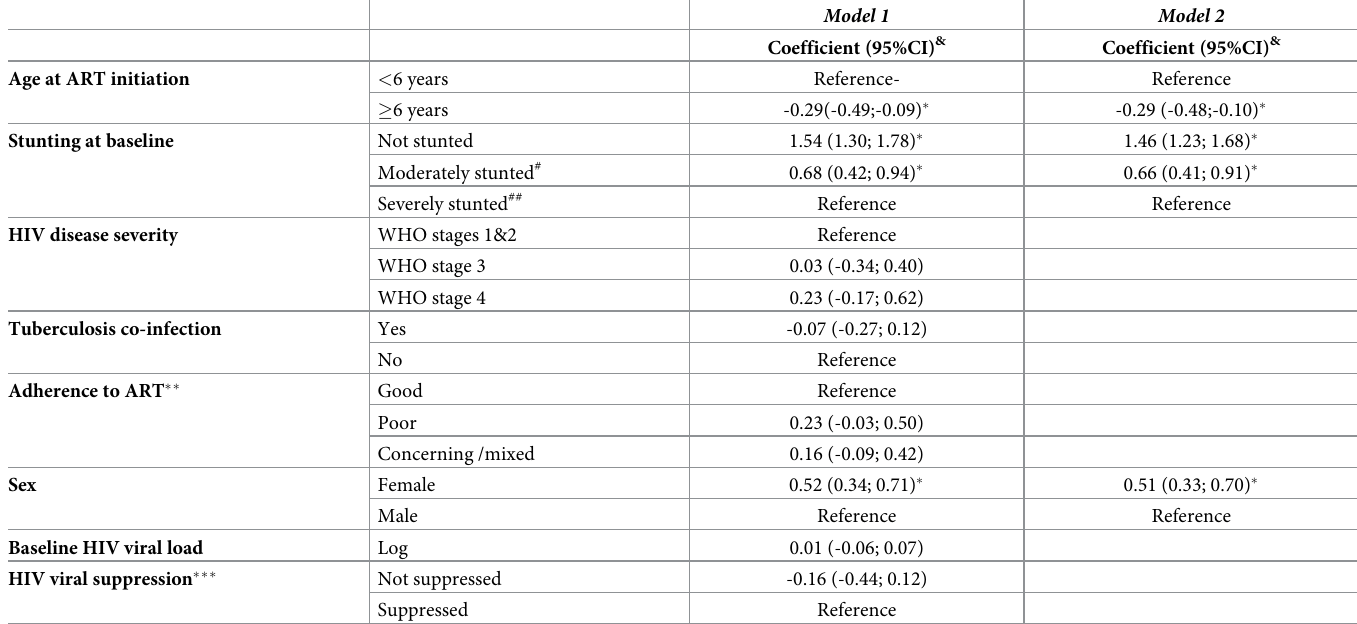
Table 4. Generalised linear mixed effects